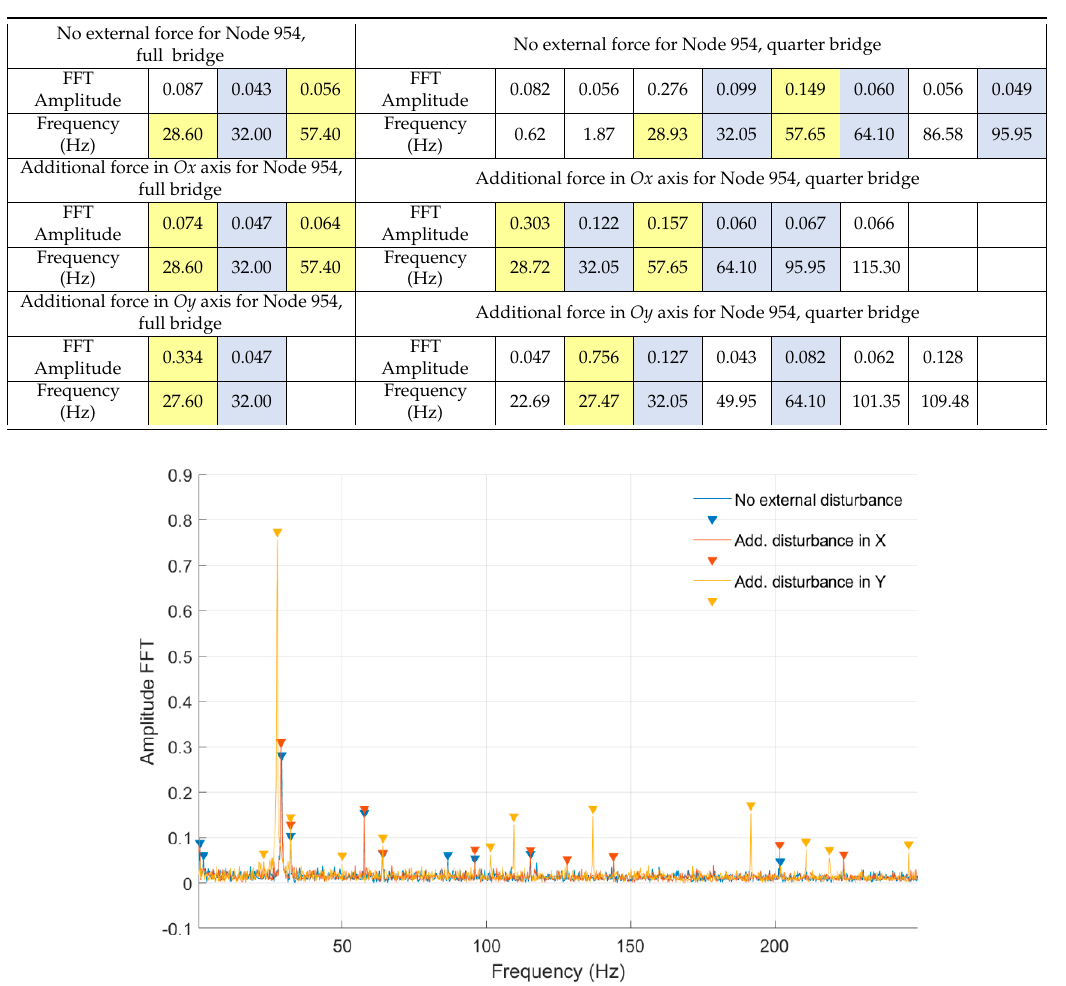
Figure 11. FFT of strain-level measurement for constant motor speed equal to 30 rev/s with disturbance from the control system for a quarter-bridge configuration (Node 954). Table 2. List of parameters read from the characteristics shown in Figures 10 and 11.